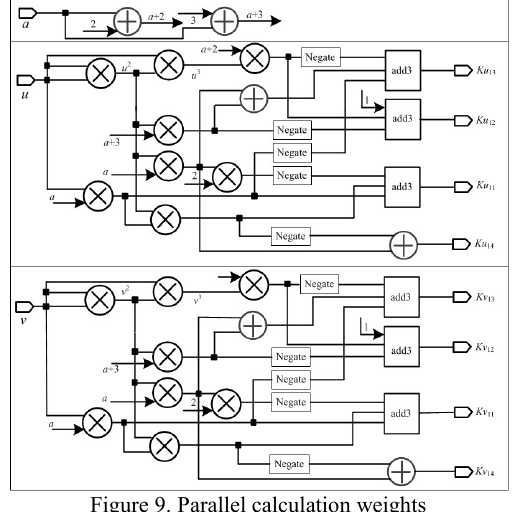
Figure 9. Parallel calculation weights 4.4 FPGA-Based Parallel Compute the